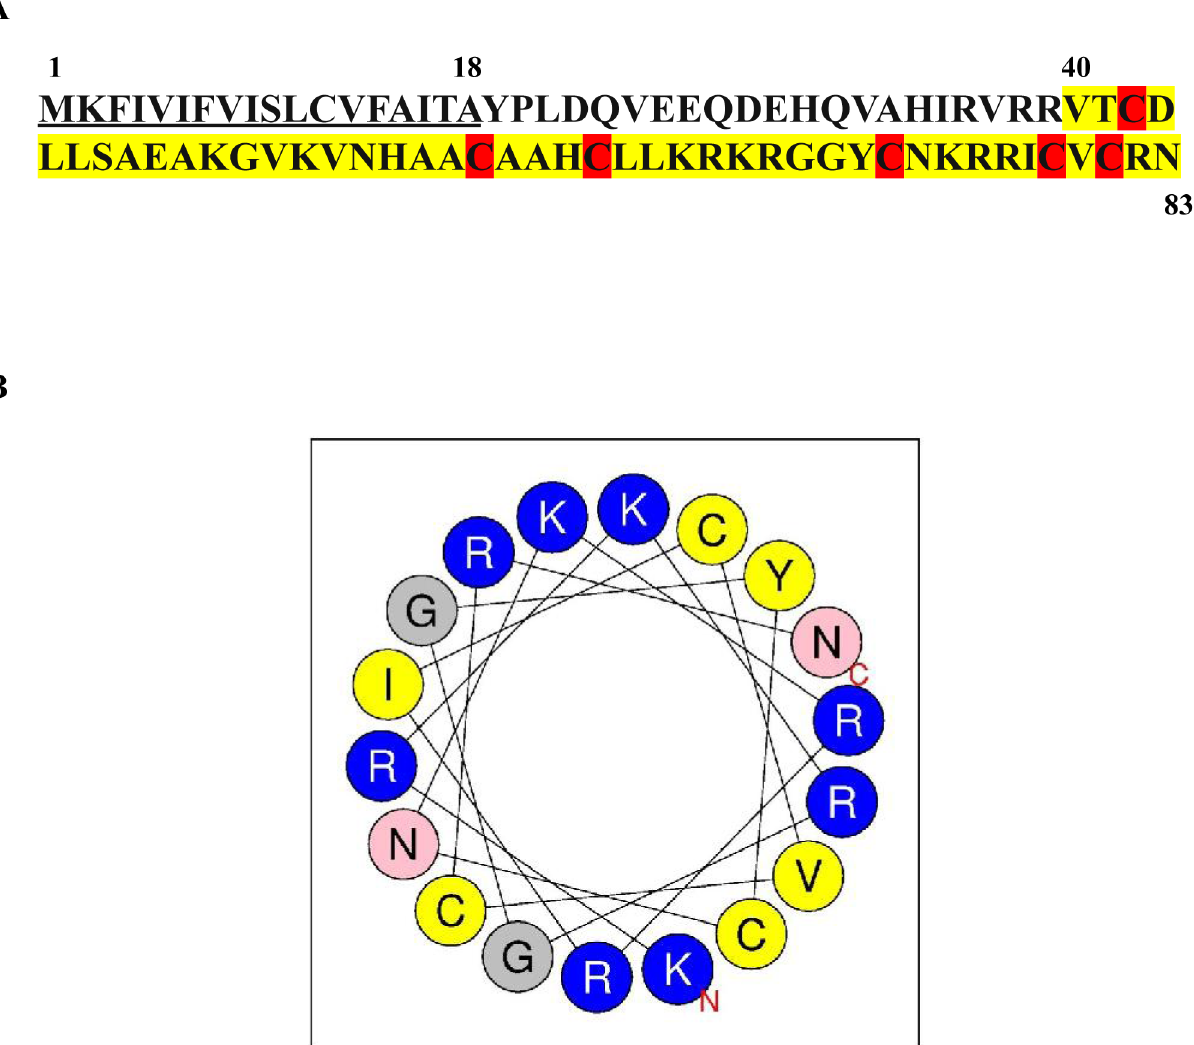
Fig 1. Amino acid sequence of defensin 1. (A) The predicted full length of the peptide is 83 a.a, the underlined region is the signal peptide cleavage site (www.predisi.de), the region highlighted in yellow represents the mature peptide sequence tested in this study. The cysteine residues that are conserved among the arthropod defensin family are highlighted in red. (B) Helical wheel diagram of residues between 66 – 83 of defensin 1 determined by the Heliquest method. Blue spheres indicate positively charged